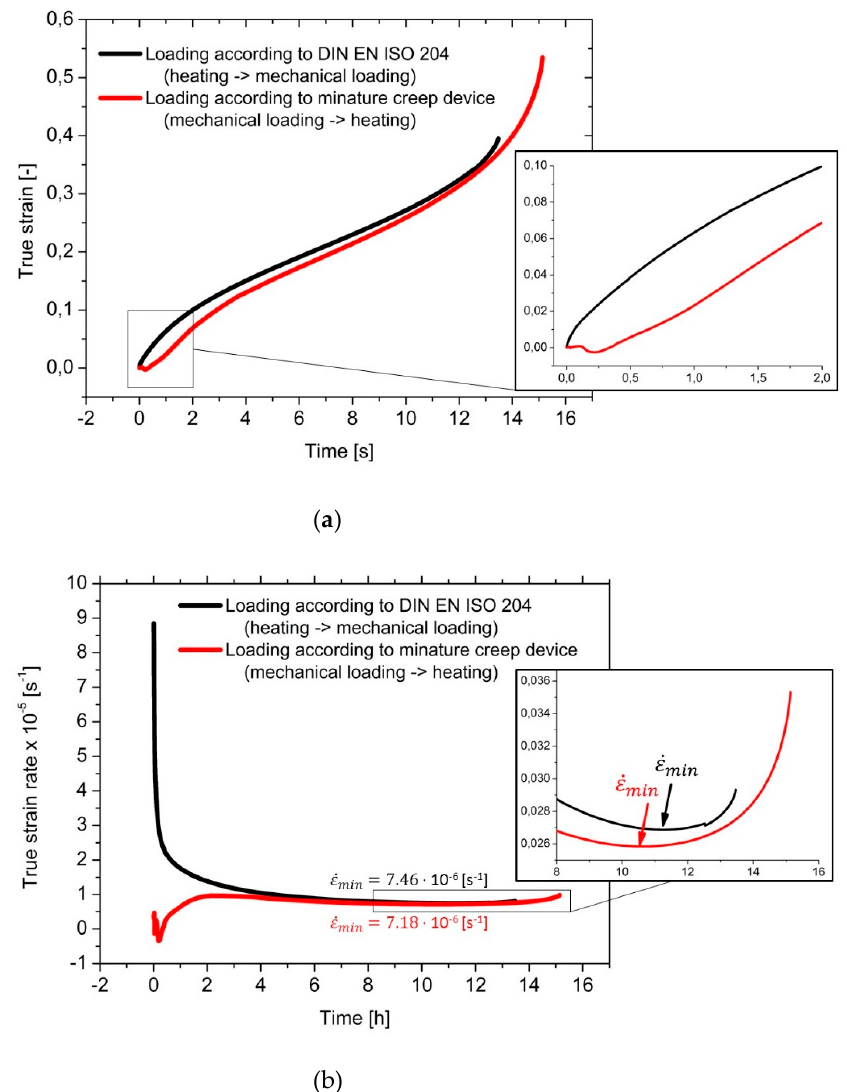
Figure 3. Comparison of different creep test procedures; ( a ) entire creep curves and detail of the very early primary creep stage, ( b ) entire curves of strain rate and detail of the region around minimum creep strain until